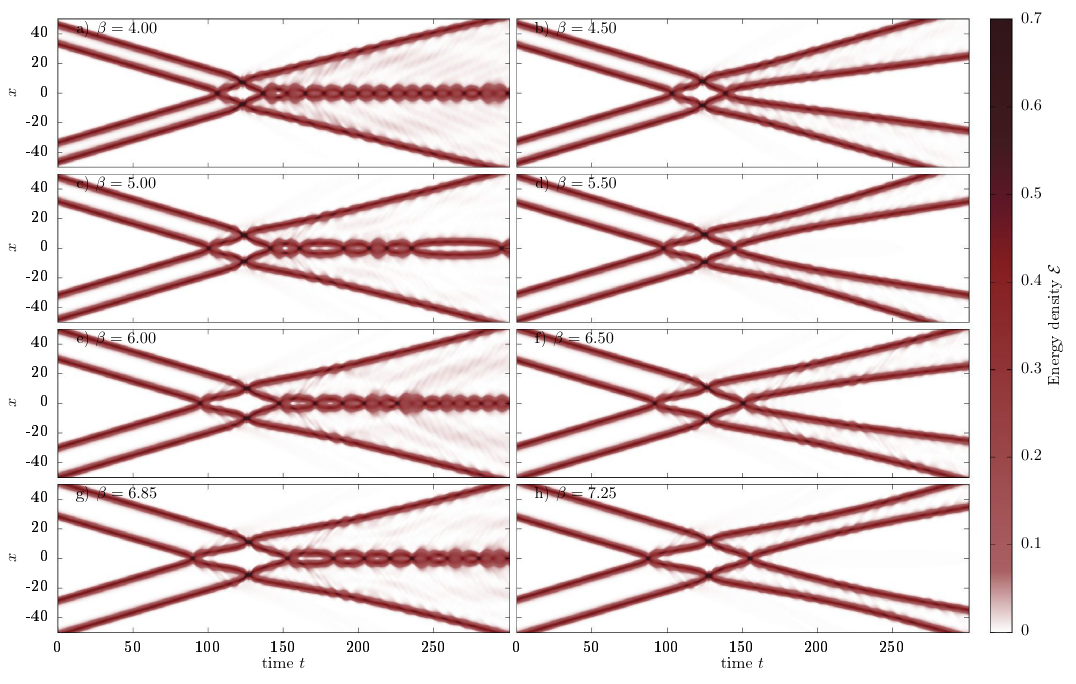
Figure 24 . Energy density plots for the collisions shown in figure